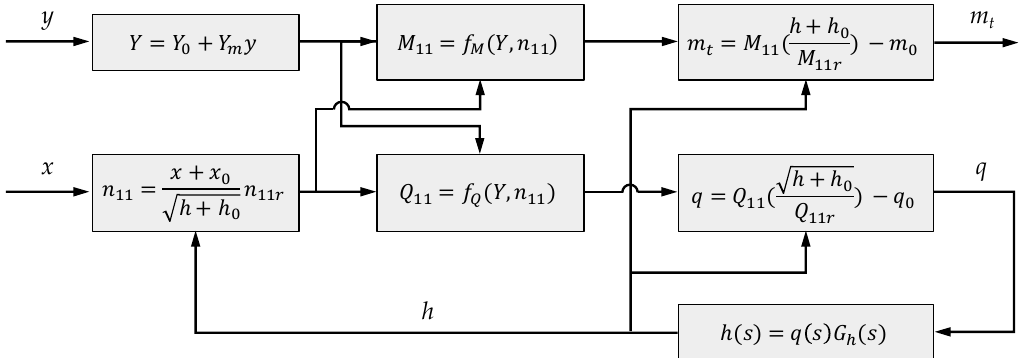
Figure 3. Block diagram of hydro-turbine model.